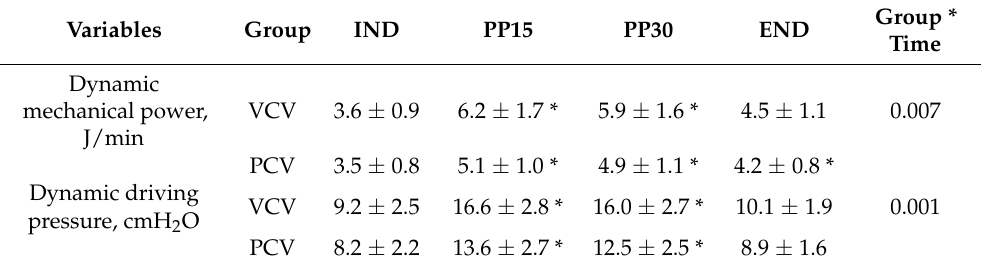
Table 2. The change in dynamic mechanical power and dynamic driving pressure during the surgery.